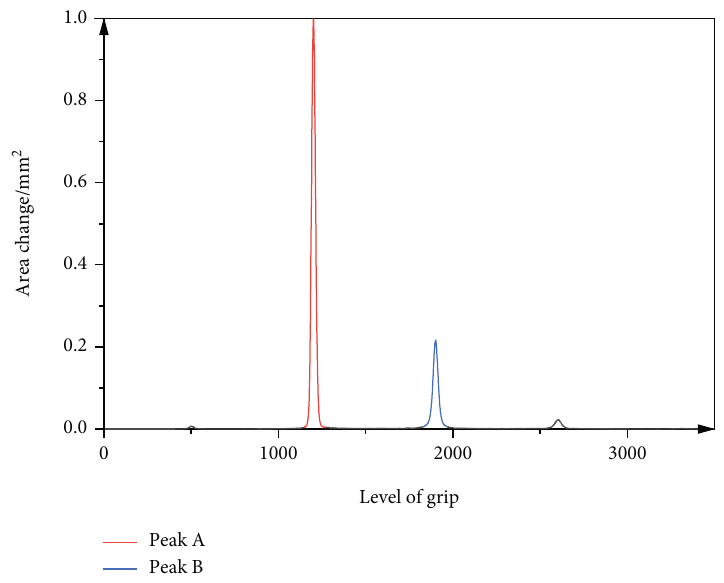
Figure 4: Change of hand contour surface hedge in vertical